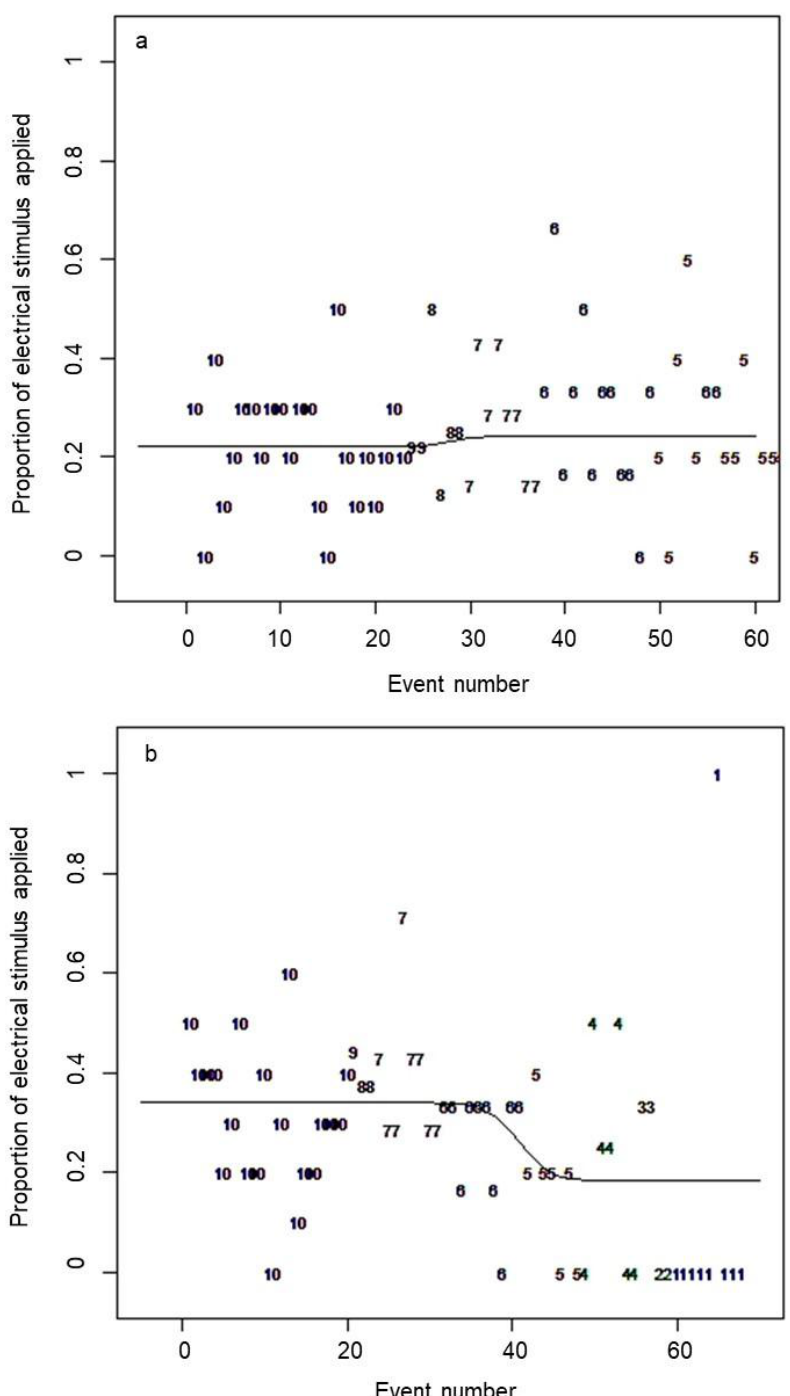
Figure 4. The logistic learning curve for: ( a ) all animals across all combined days; and ( b ) all animals across all combined days but with the grazing algorithm’s two additional audio cues removed. The y -axis is the proportion of animals testing the fence line that received an electrical stimulus and the x -axis is the number of individual events or interactions with the fence line (i.e., one animal receiving a single cue is a single event). The numerals are the number of animals that tested the fence line at each event number (i.e., ( a ) all ten animals interacted with the fence at least once, but only five animals interacted 60 times or more). Animal 5 was removed from these datasets as there was a functionality error in the delivery of the electrical stimulus negating accurate determination of associative learning. Across all events, approximately 25% of animals received an electrical